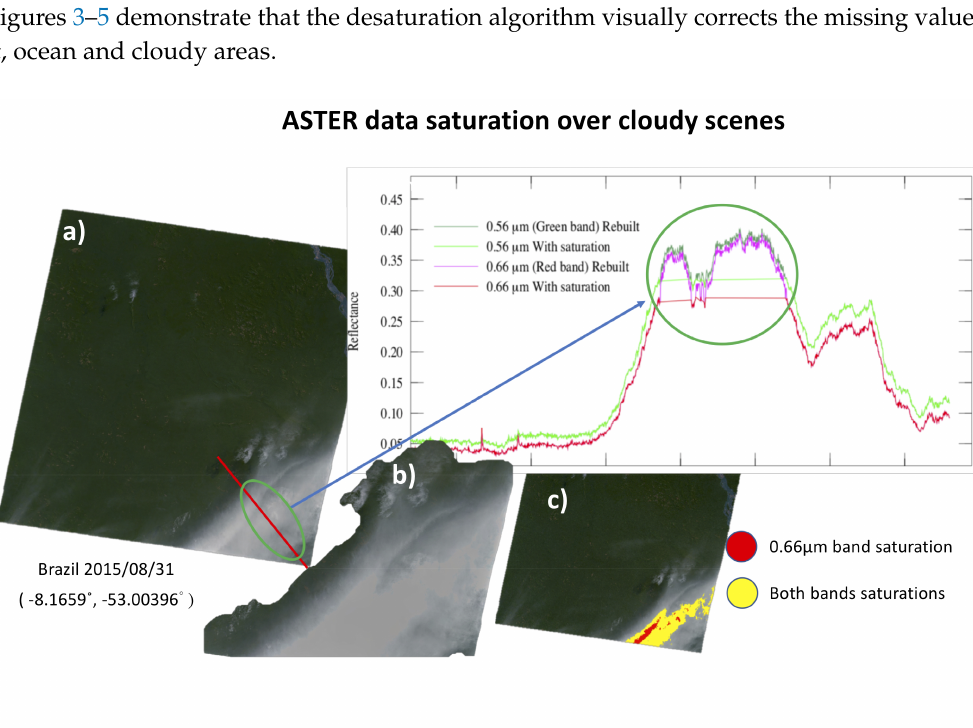
Figure 3. Visualization of the saturation corrections over cloudy areas: ( a ) final true color composite; ( b ) original saturated granule; ( c ) mask of the saturated areas (in red for the 0.66µm band and in yellow for both 0.56 and 0.66µm